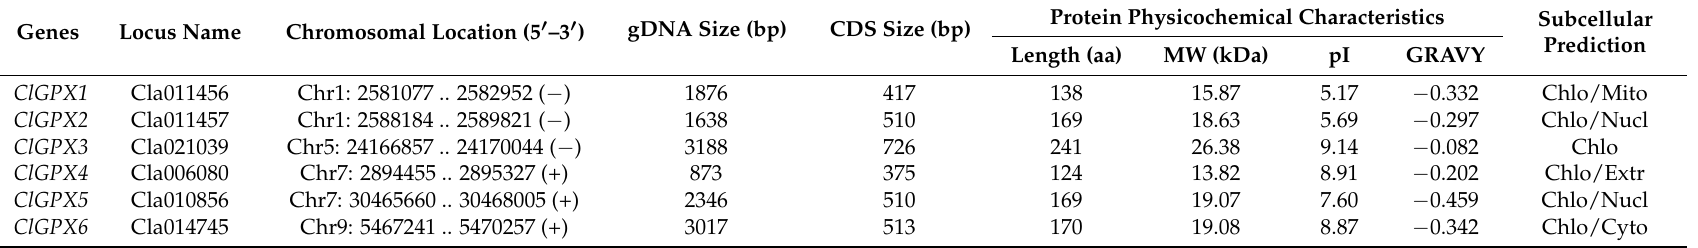
Table 1. A list of watermelon glutathione peroxidase ( GPX ) gene family members and their related information.